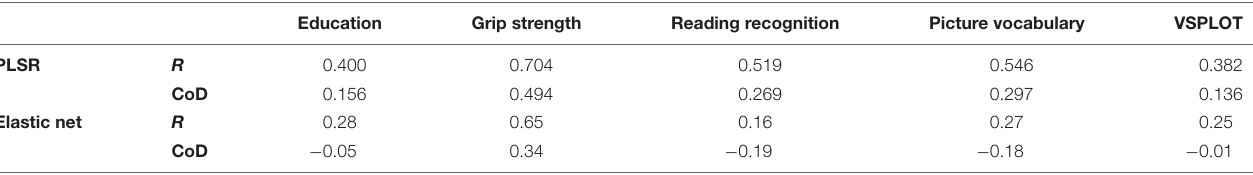
TABLE 3 | Comparison of the estimations based on PLSR in this study to those based on elastic net listed on the HCP website ∗